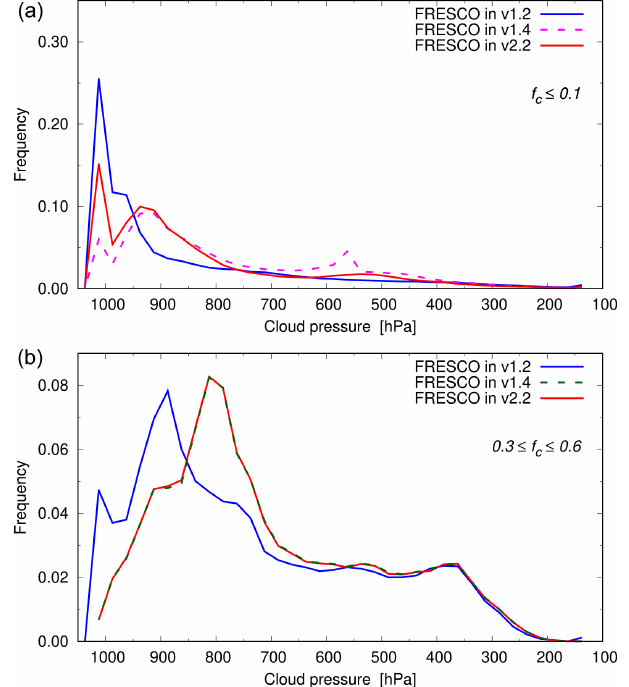
Figure 7. Cloud pressure frequency distribution from orbit 03707 on 1 July 2018, considering only ocean and land ground pixels that are free of snow/ice, for small (a) and medium (b) cloud fractions, with a bin size of 25hPa and f c the cloud fraction in the NO 2 fit window. Shown are curves from the FRESCO retrievals in the pub- lic v1.2 data (solid blue lines), its implementation in the v1.4 frame- work with the use of level-1b v1.0 spectra (dashed magenta line), and with level-1b v2.0, i.e. from DDS-2 (solid red line). Note that in (b) the v1.4 and v2.2 lines overlap.